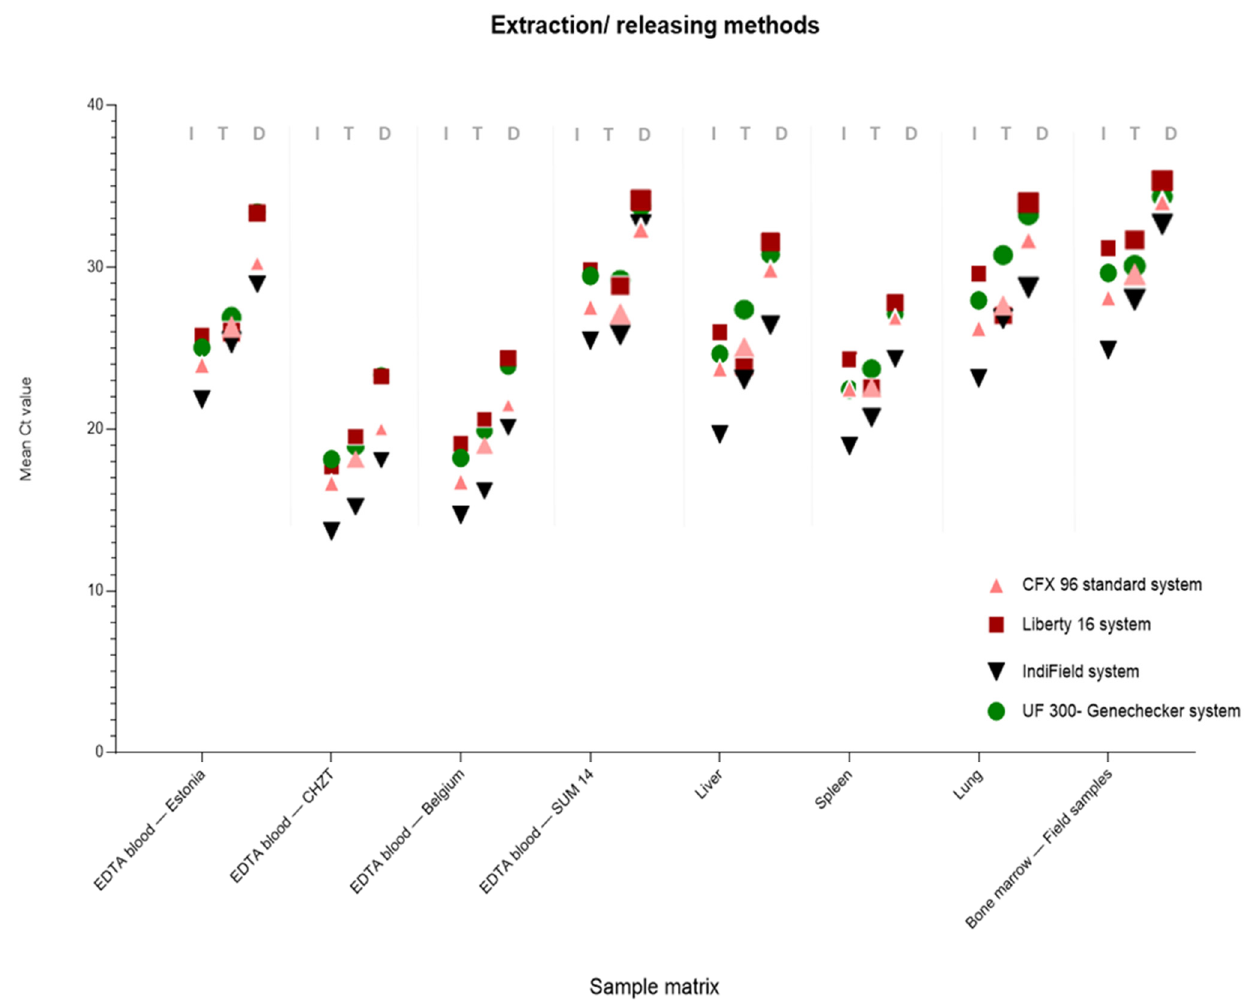
Figure 1. Comparison of the four different qPCR systems based on the three different extraction/releasing procedures. (I = standard automated IndiMag 48 extraction system; T = Triple E manual extraction system; D = released DNA amplified via direct qPCR). For the analyses, the qPCR results of different sample matrices from 22 animals, infected with several ASF virus strains, were used (see detailed information in the Methods and Materials